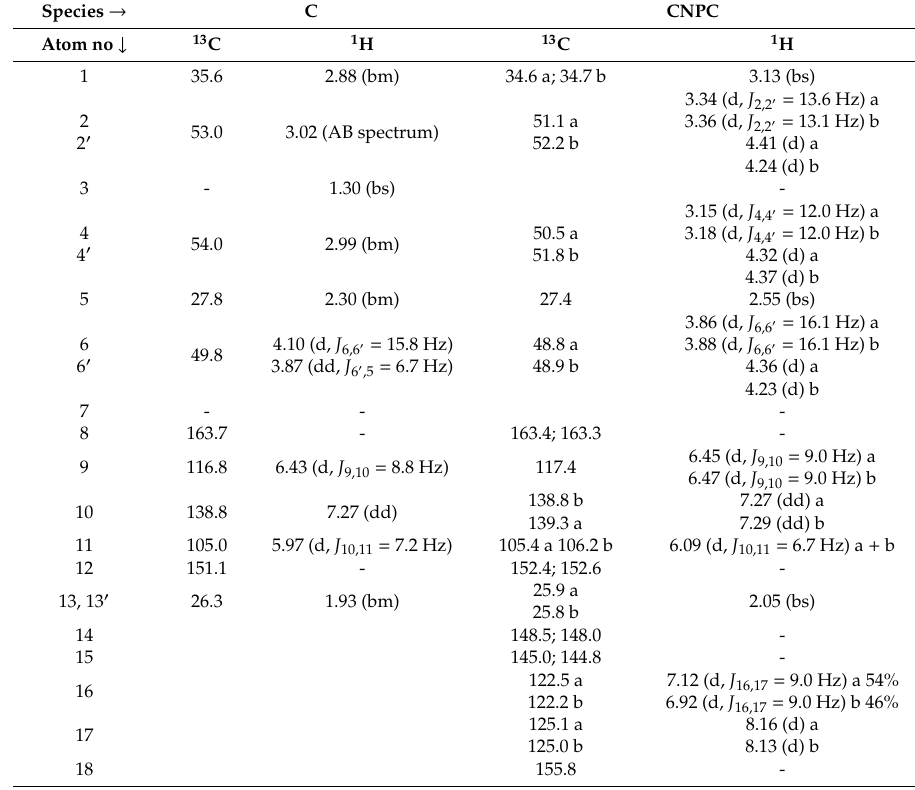
Table 1. The 1 H and 13 C-NMR signal assignments for CNPC in comparison with C based on 2-D COSY (Figure 2B) and HSQC and HMBC (Figure 3B) experiments in CDCl 3 . Species → C CNPC Atom no ↓ 13